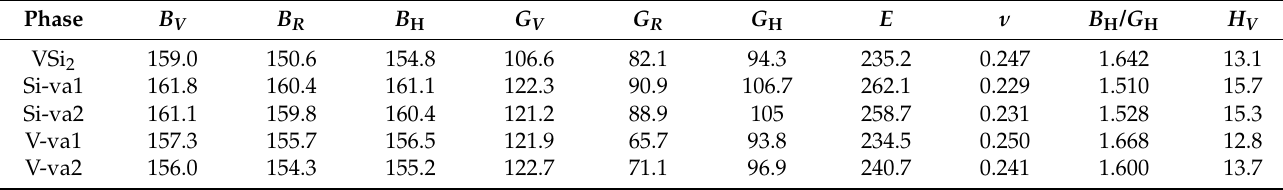
Table 4. Calculated bulk modulus, B (GPa), shear modulus, G (GPa), Young’s modulus, E (GPa) Poisson’s ratio, v and Vickers hardness, H V (GPa) of C11 b -VSi 2 with various